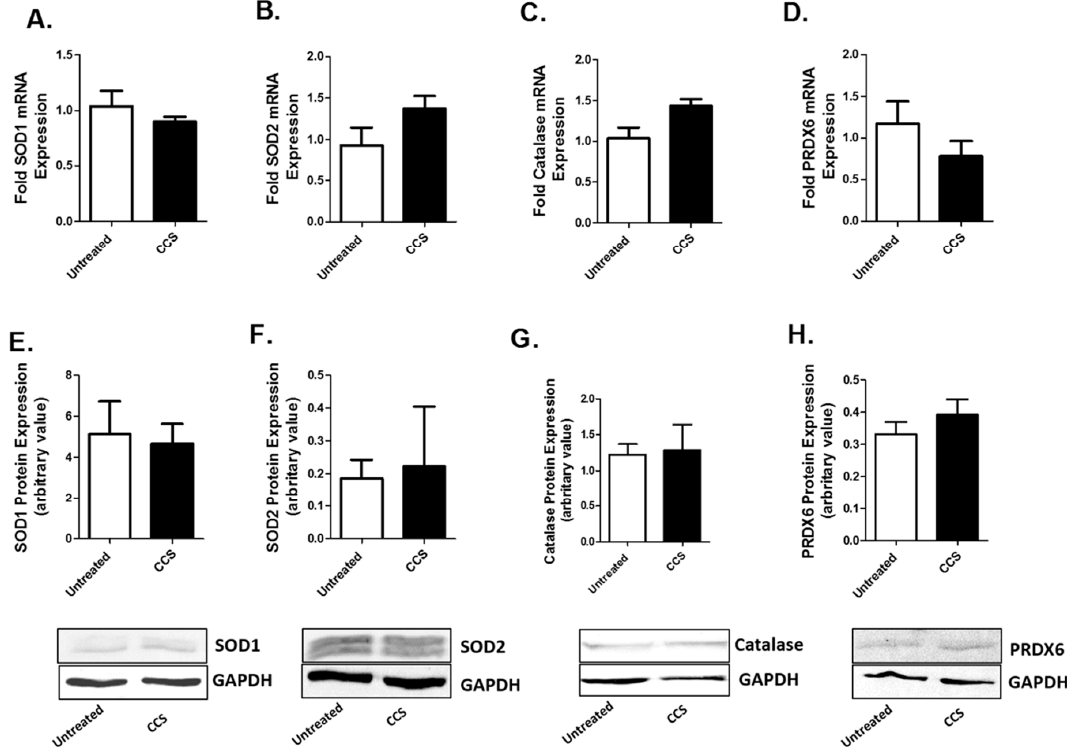
Figure 3. Caski cell culture supernatant (CCS) alters antioxidant enzyme (AOE) expression in differentiated U1 cell line. Differentiated U1 cell line was treated with 250 µL of CCS every 24 h for 4 days. Expressions of SOD1, SOD2, catalase, and PRDX6 were monitored at mRNA ( A–D ) and protein ( E–H ) levels in the treated cells. Data were obtained from the mean of at least three independent experiments with the error bars representing the standard error of the mean.